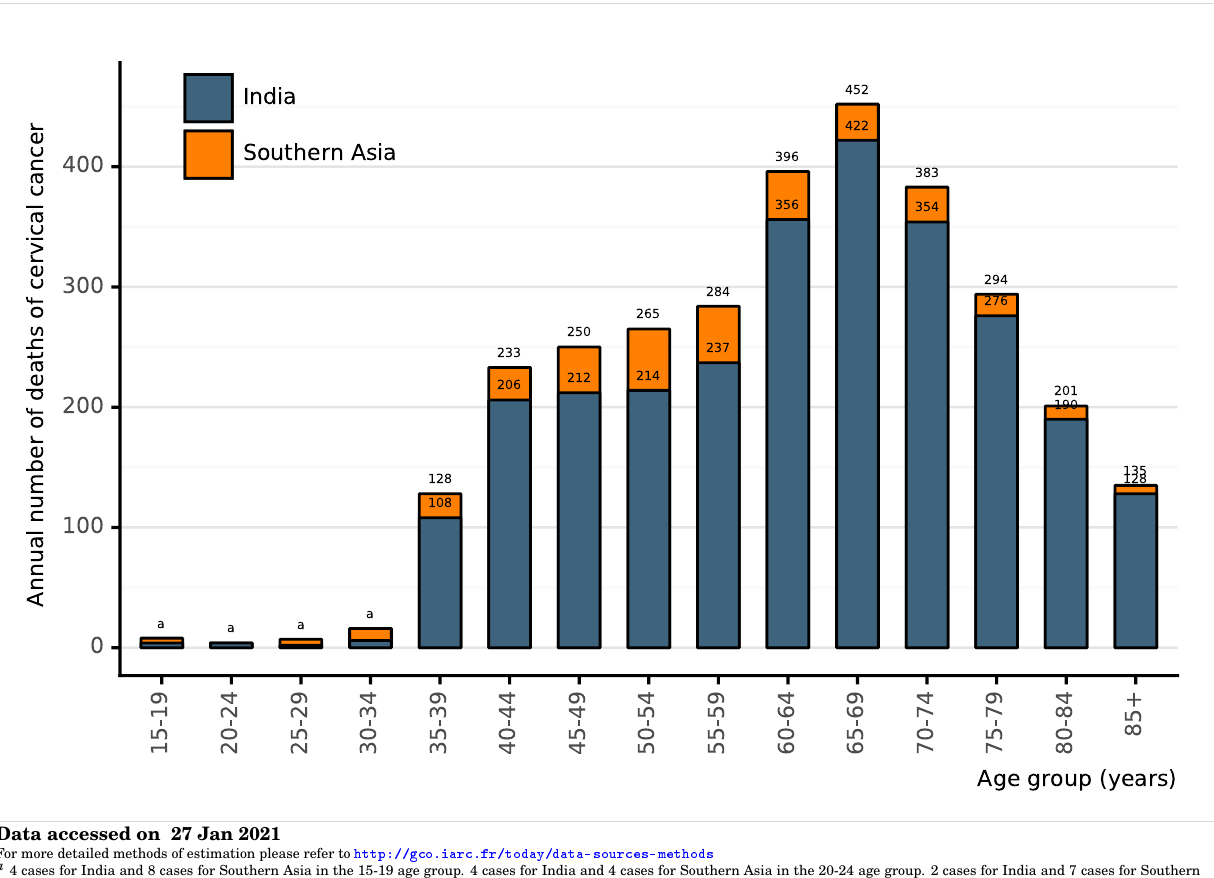
Figure 117: Annual number of deaths of cervical cancer by age group in India (estimates for